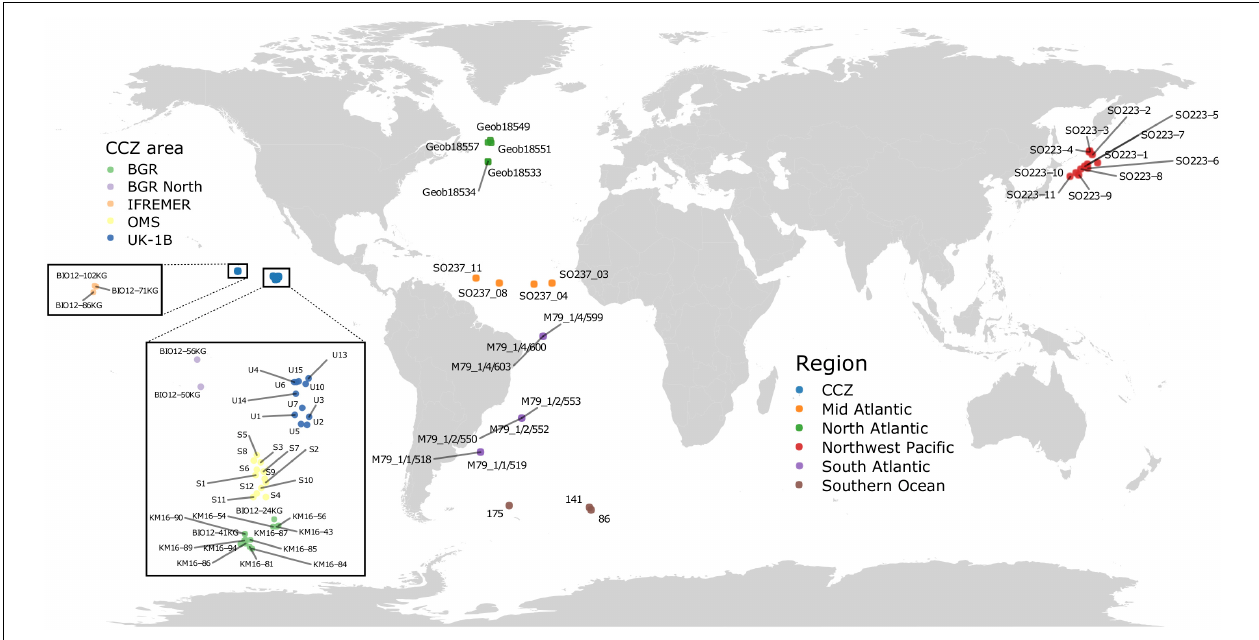
FIGURE 1 | Location of the sequenced sediment samples. Samples in the Pacific Ocean include two regions: the CCZ (five different areas, see inset) and the Northwest Pacific (Kuril-Kamchatka area). Samples in the Atlantic Ocean include three regions (North, Mid, and South Atlantic), as well as three areas (and stations) in the Southern Ocean